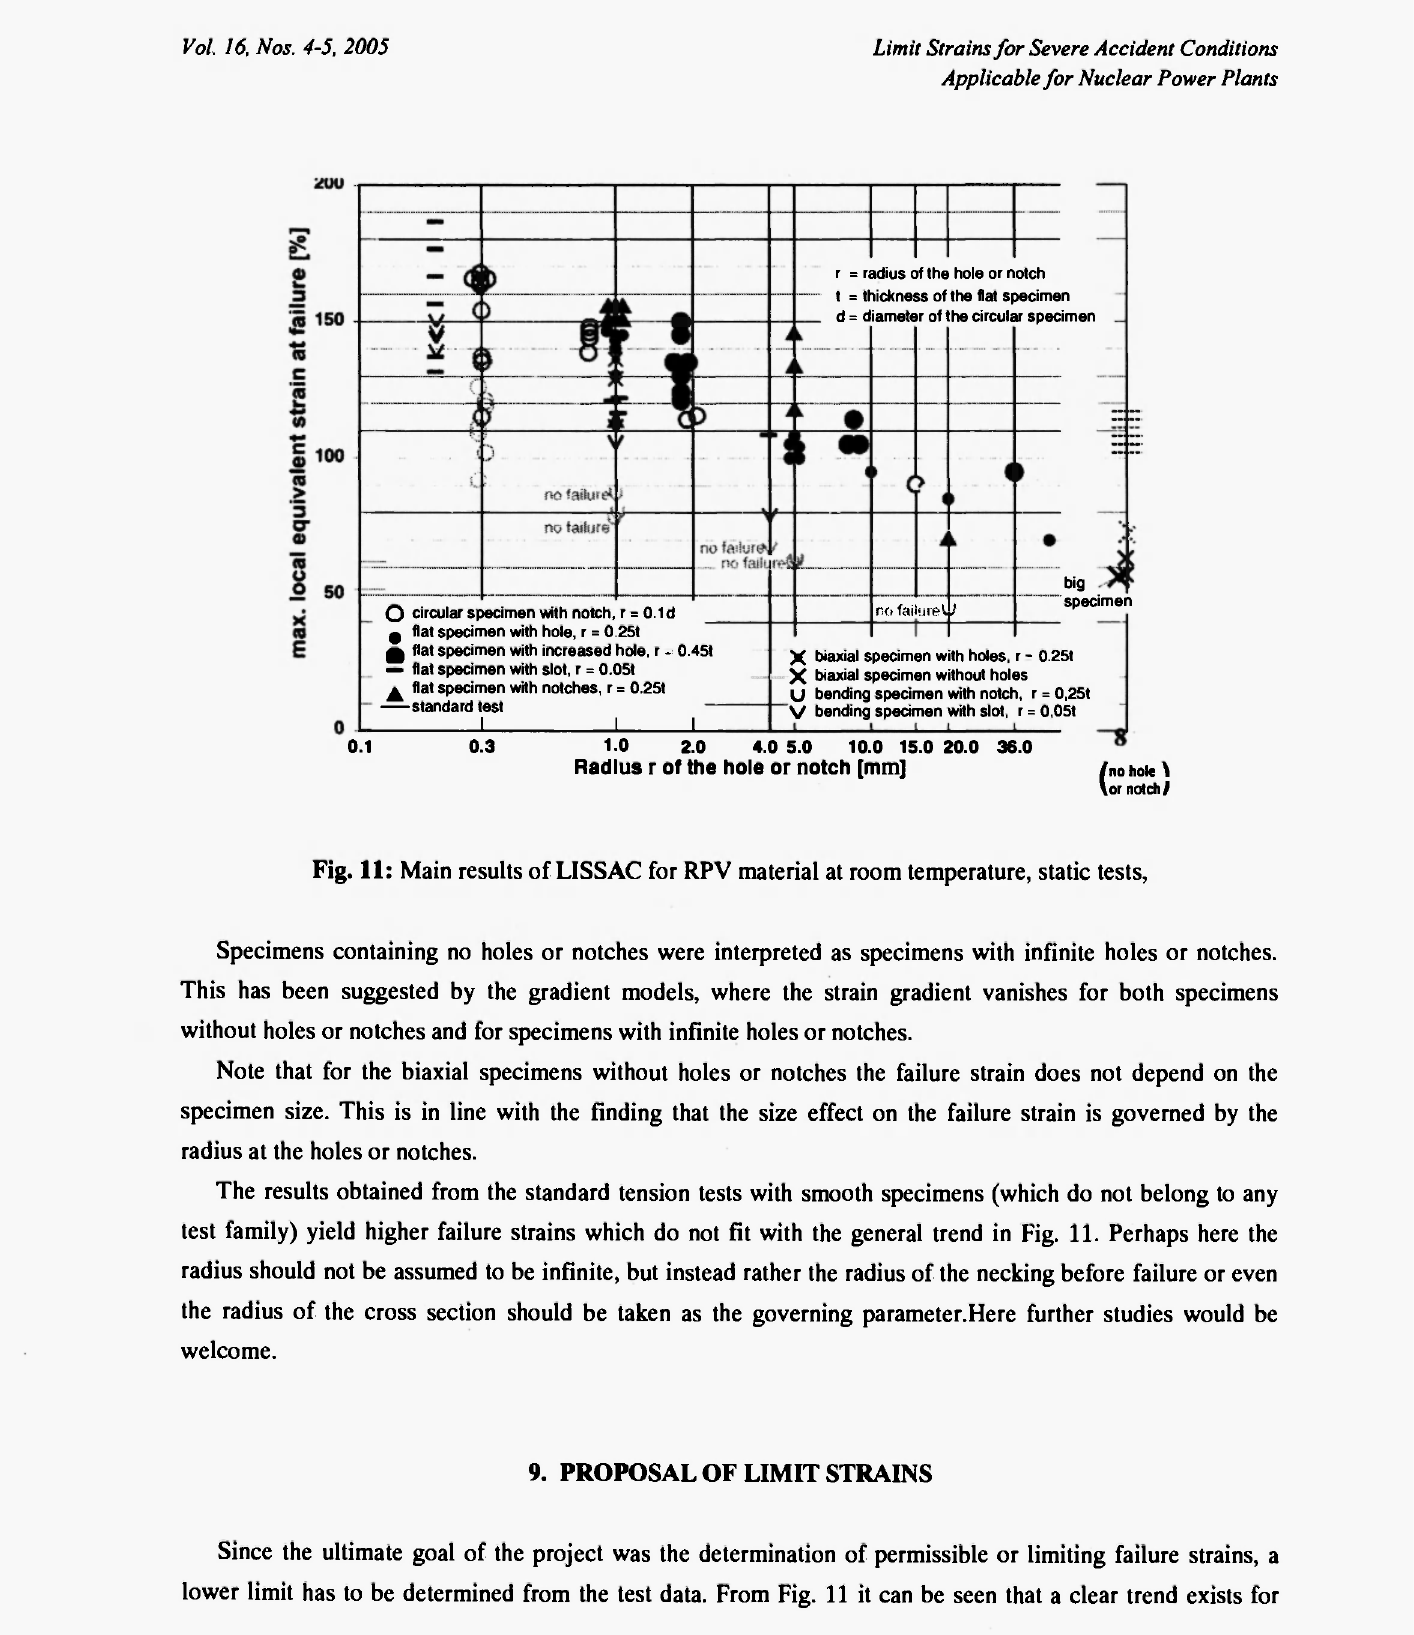
Specimens containing no holes or notches were interpreted as specimens with infinite holes or